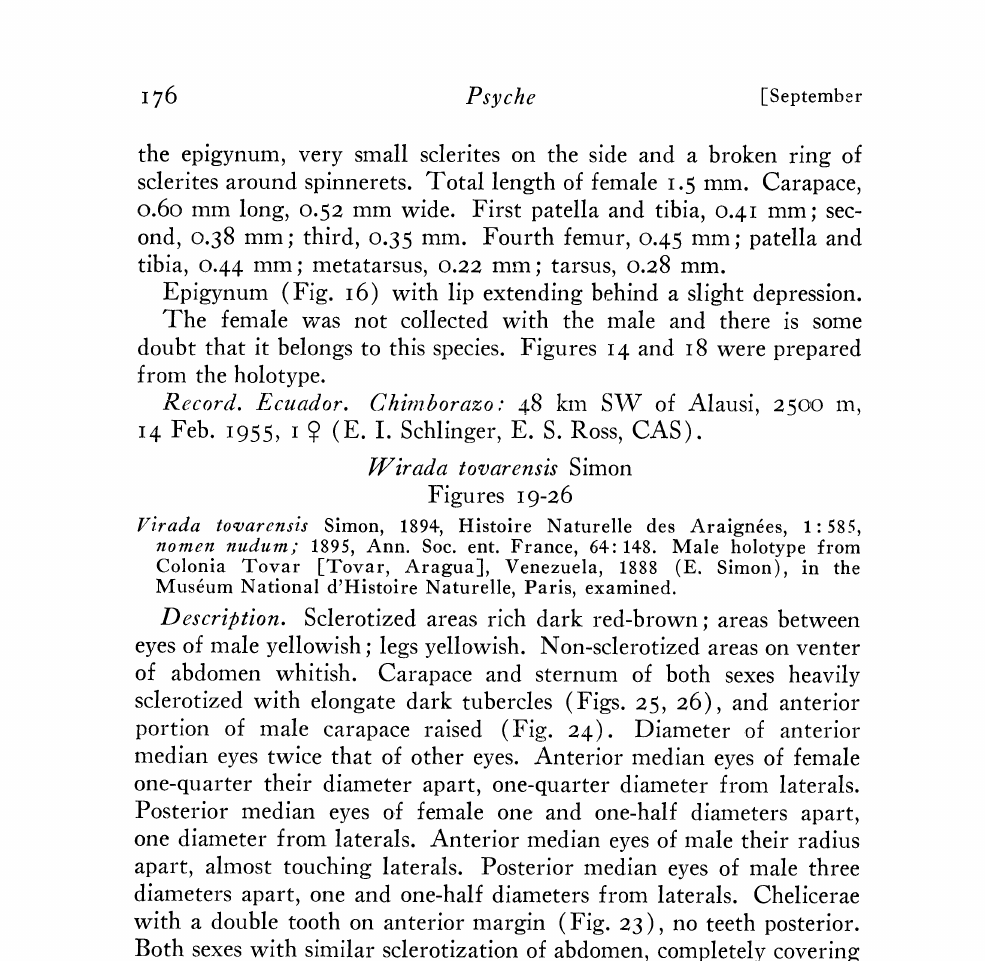
Colonia Tovar [Tovar, Aragua], Venezuela, 1888 (E. Simon), in the Mus4um National d’Histoire Naturelle, Paris, examined. Description. Sclerotized areas rich dark red-brown; areas between eyes of male yellowish; legs yellowish. Non-sclerotized areas on venter of abdomen whitish. Carapace and sternum of both sexes heavily sclerotized with elongate dark tubercles (Figs. 25, :z6), and anterior portion of male carapace raised (Fig. 24). Diameter .of anterior median eyes twice that of other eyes. Anterior median eyes of female one-quarter their diameter apart, one-quarter diameter from laterals. Posterior median eyes o.f female one and one-half diameters apart, one diameter from laterals. Anterior median eyes of male their radius apart, almost touching laterals. Posterior median eyes of male three diameters apart, one and one-half diameters from laterals. Chelicerae with a double tooth on anterior margin (Fig. 23), no teeth posterior. Both sexes with similar sclerotization of abdomen, completely covering dorsum, a smaller shield on venter and a sclerotized ring around spinnerets. The abdomen is flattened (Fig. 24), slightly thicker in female than in male. Male with first leg slightly longer than fourth; female with fourth leg slightly longer than first. Total length of female I.O mm. Carapace 0.55 mm long, o.47 mm wide, o.3o mm high. First patella and tibia, o.3:z mm; second, o.31 mm; third, o.26 mm. Fourth femur, o.35 mm; patella and tibia, o.39 mm; meta- tarsus, o.18 mm; tarsus, o.23 mm. Total length of male I.O mm. Carapace o.47 mm long, o.45 mm wide, o.35 mm high in eye region. First femur, o.39 mm; patella and tibia, o.39 mm; metatarsus, o.22 mm; tarsus, o.27 mm. Second patella and tibia, o.3: mm; third, o.29 mm; fourth, o.39